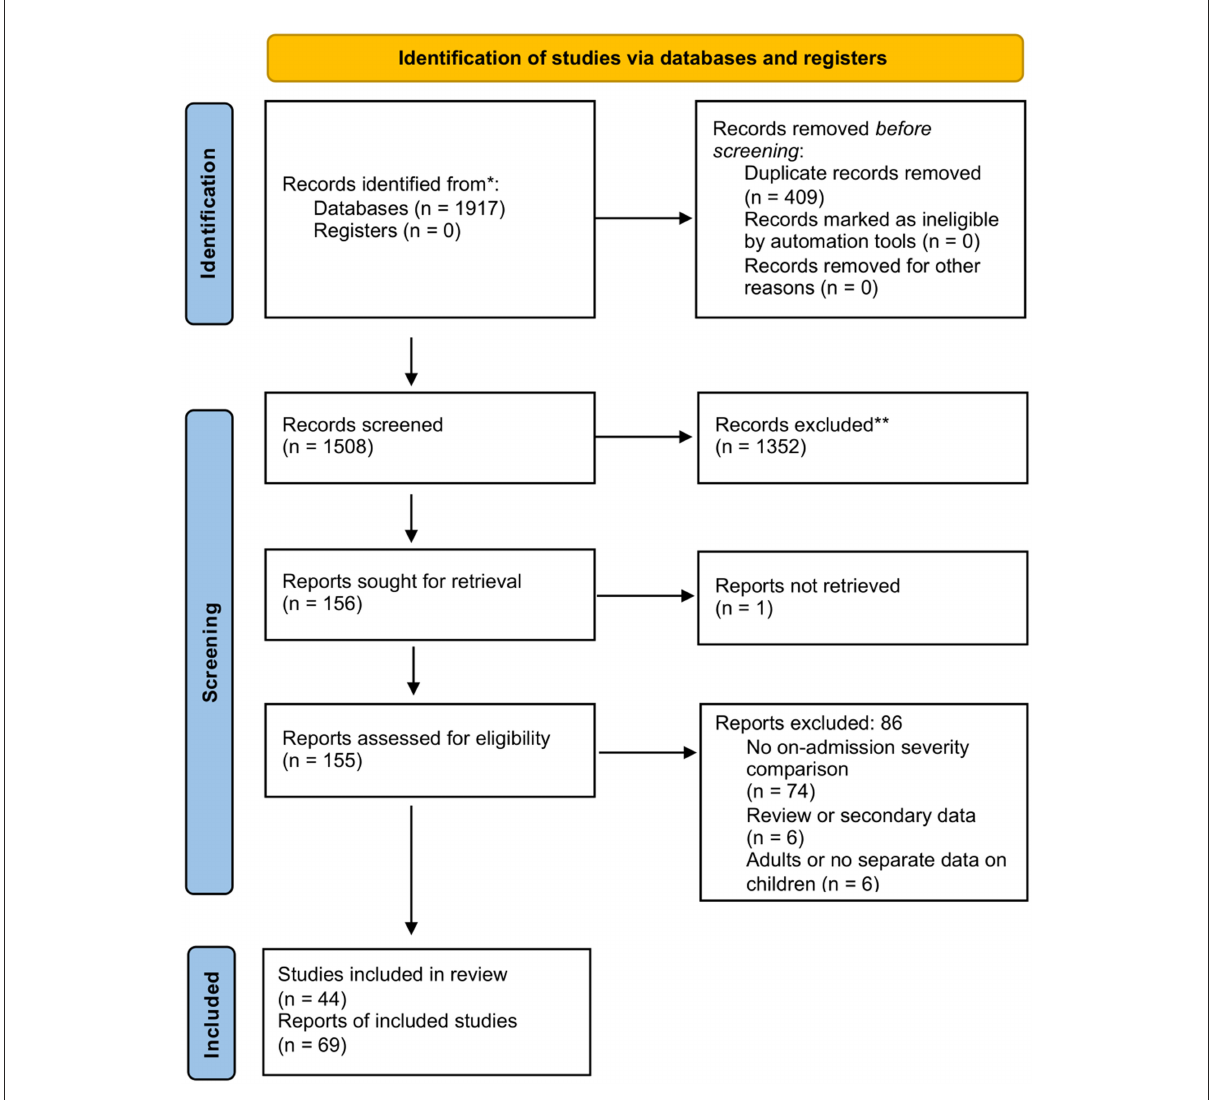
FIGURE1 PRISMA flow diagram. The selection of reports is visualized. n :